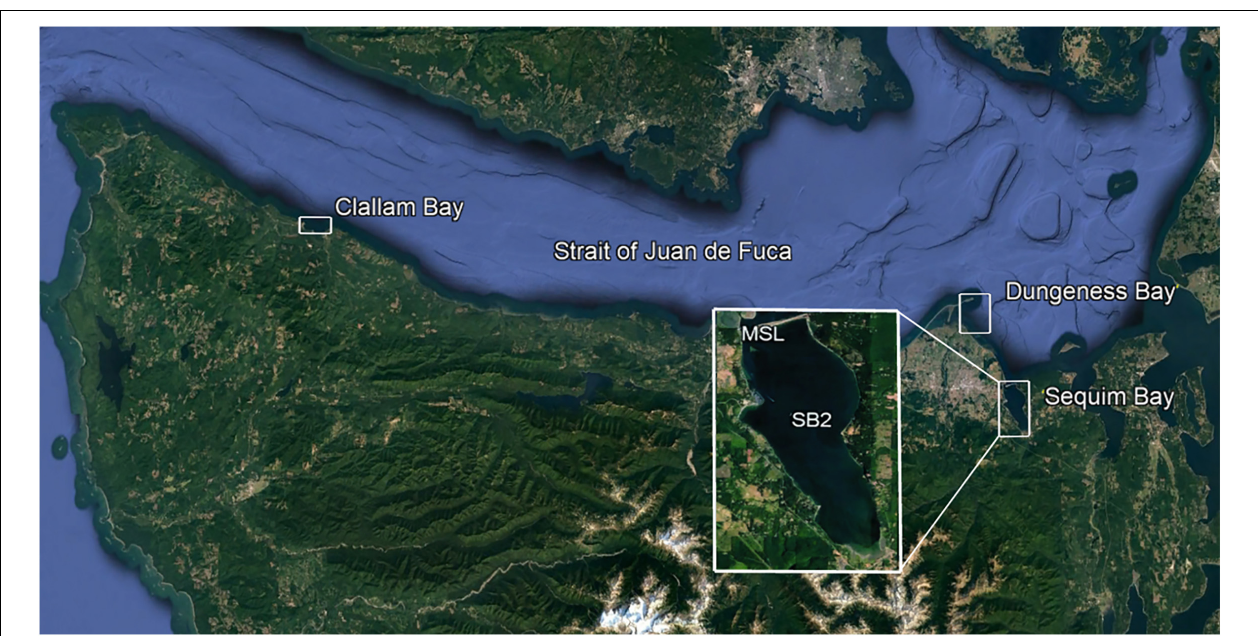
FIGURE 1 | Triton Initiative test sites: SB2, MSL, Dungeness Bay, and Clallam Bay, located along Washington State’s (United States) northern